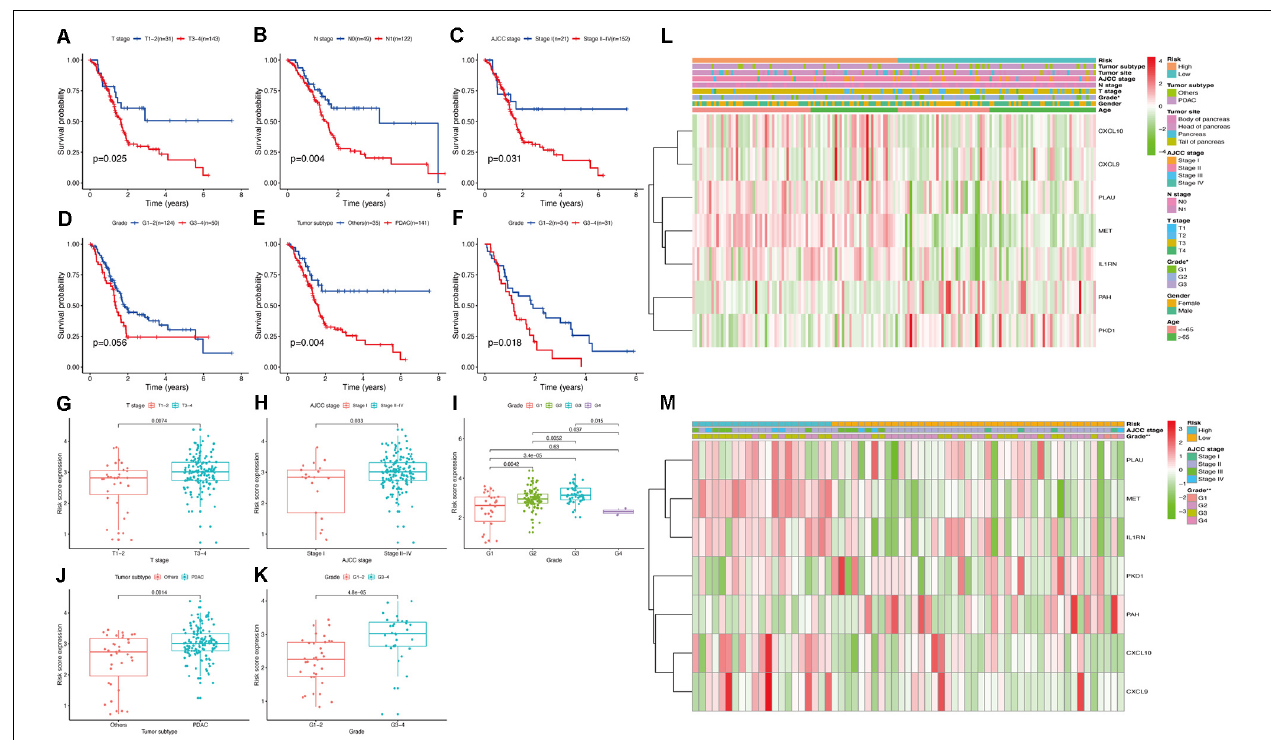
FIGURE 8 | Evaluation the relationship between the risk score and clinicopathological parameters in patients with PC. (A–E) Survival curve of clinicopathological characters in TCGA cohort. (F) Survival curve of clinicopathological characters in validation cohort. (G–J) Correlation analysis between the risk score and clinicopathological characters in TCGA cohort. (K) Correlation analysis between the risk score and clinicopathological characters in validation cohort. The heatmap shows the distribution of clinicopathological features and OS genes expression in two risk subgroups from the TCGA (L) and validation (M)